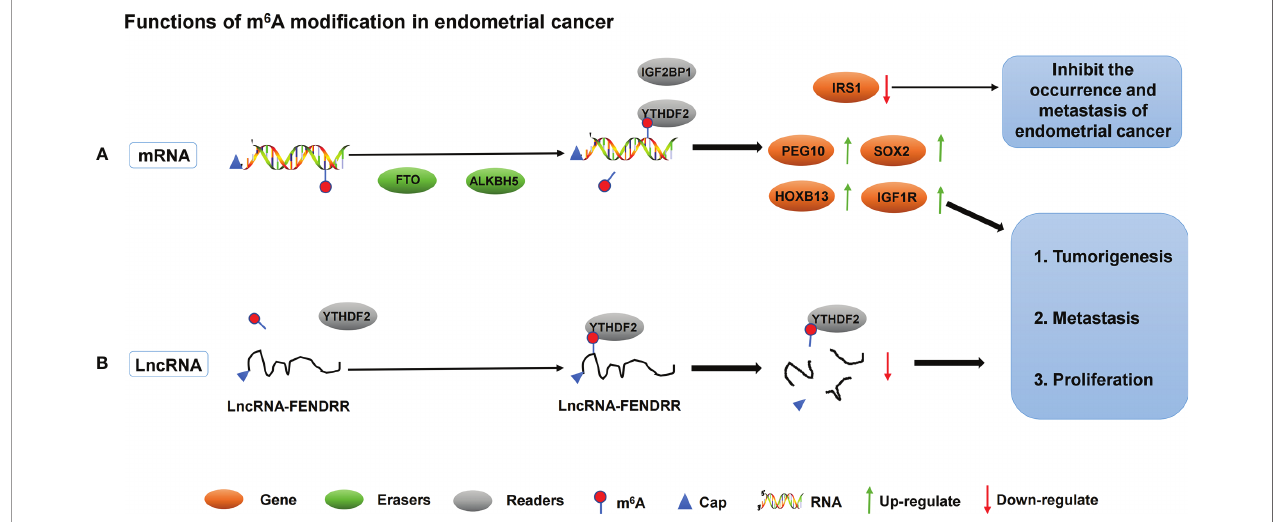
FIGURE 3 | The roles of different m 6 A regulators in regulating RNAs in endometrial cancer. (A) m 6 A methylation regulators ALKBH5, FTO, IGF2BP1 and YTHDF2 promote/inhibit the invasion and metastasis of endometrial cancer by binding to mRNA and regulating mRNA expression. (B) m 6 A methylation regulators YTHDF2 promote the invasion and metastasis of endometrial cancer by binding to lncRNA-FENDRR and down- regulating lncRNA-FENDRR